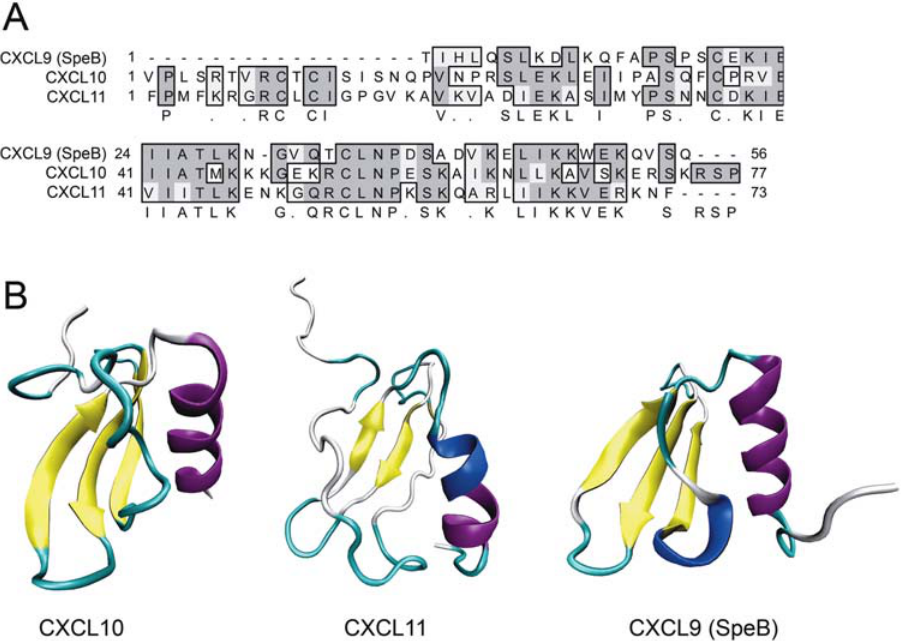
Figure 6. Sequence and structural comparison of CXCL10, CXCL11, and SpeB-processed CXCL9. Panel A: ClustalW alignment of the SpeB-generated fragment of CXCL9 (18–73) with mature CXCL10 and CXCL11. Amino acid identities are shown in dark grey, similarities in light grey, and consensus sequence is shown under the alignment. Panel B, visualization of the known structures of mature CXCL10 and CXCL11, and homology model of the SpeB-generated CXCL9 fragment (18–73) using a CXCL7 -variant as the template. H -strands are shown in yellow, Æ -helices in purple, 3 10 - helices in blue, and loops in turquoise.